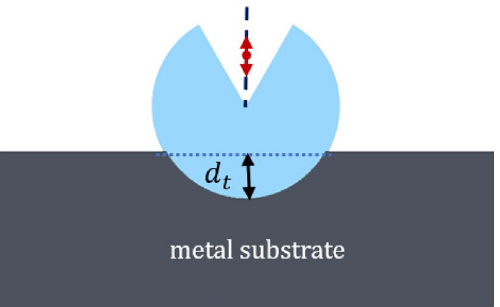
Figure 6. The silicon spherical resonator of Fig. 1 as loaded on the metal substrate. The substrate sag outlined by the overlying resonator body is characterized by the depth d t . For numerical purposes we consider a silver substrate.